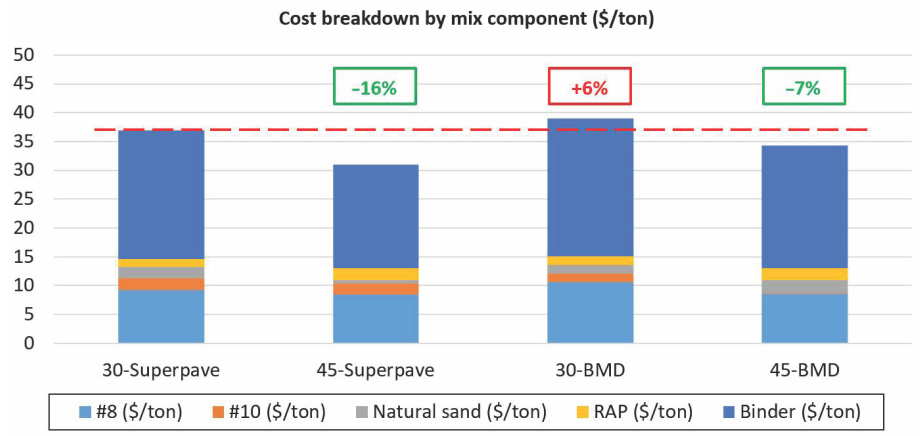
Figure 9. Mix cost comparison.